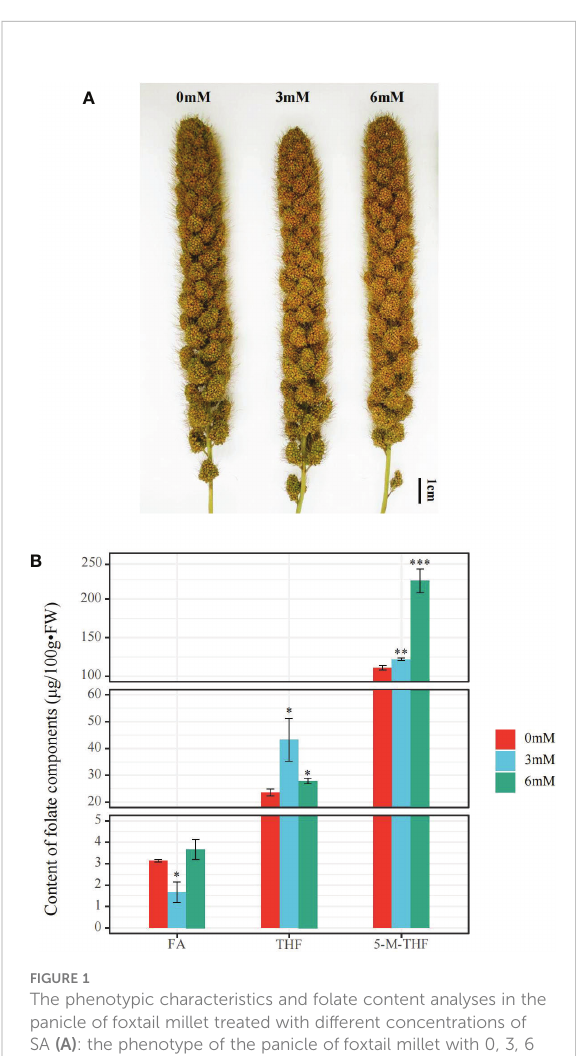
FIGURE 1 The phenotypic characteristics and folate content analyses in the panicle of foxtail millet treated with different concentrations of SA (A) : the phenotype of the panicle of foxtail millet with 0, 3, 6 mM SA treatment. (B) : the FA (Folate), THF (Tetrahydrofolate), and 5-M-THF (5-methyltetrahydrofolate) content of the panicle of foxtail millet with above SA treatment. “ * ” indicates signi fi cant difference (p < 0.05), “ ** ” and “ *** ” indicate extremely signi fi cant differences (p<0.01 and